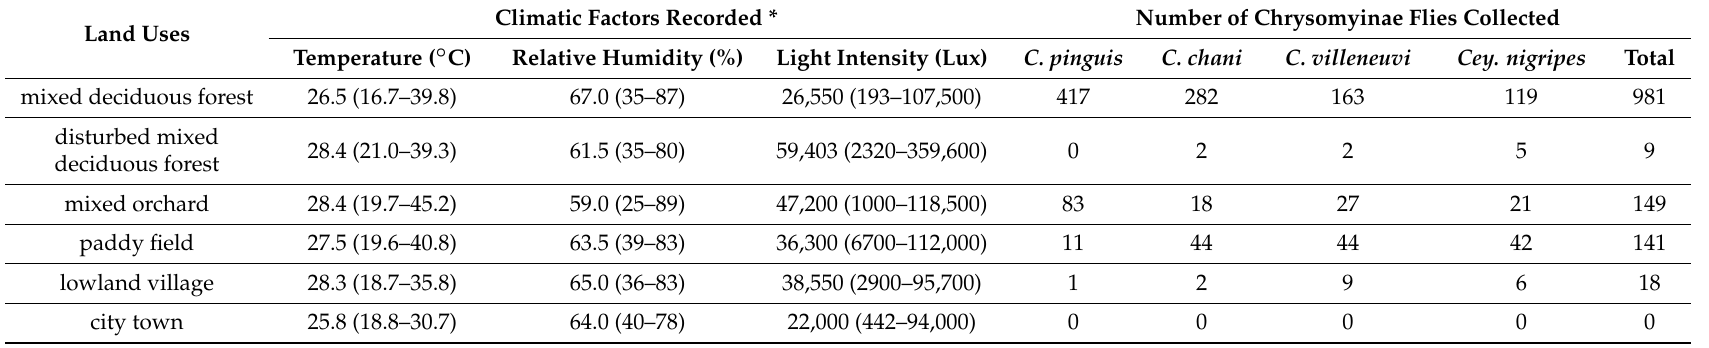
Table 1. Climatic factors (temperature, relative humidity, and light intensity) recorded and total numbers of Chrysomyinae flies collected at each land use types. Land